Question: Describe this figure in one sentence.
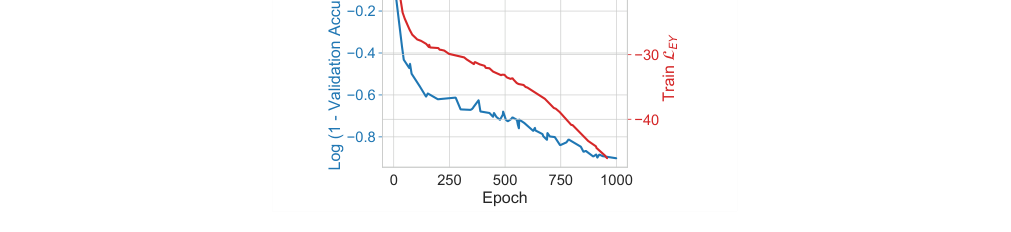
Answer: Correlation of SSL-EY’s learned embeddings with downstream task performance, indicat- ing untapped representational capacity.